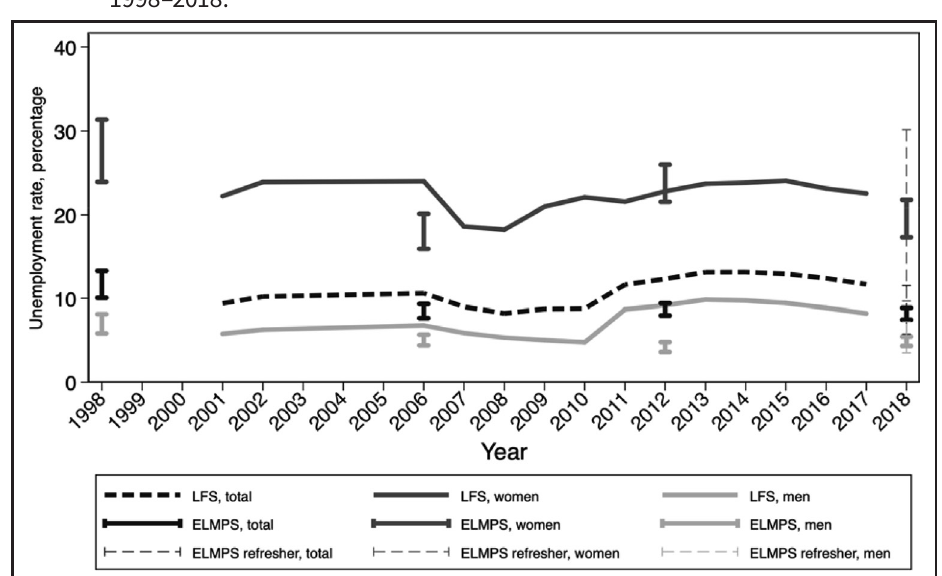
Unemployment rates (percentage) by sex and data source, ages 15–64, 1998–2018.